Question: Give a one-sentence summary of this figure.
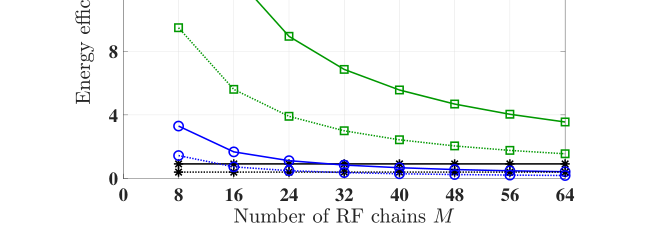
Answer: , Fig. 9 and Fig. 10 compare the energy efficiency versus the number of RF chains, number of UEs and number of RHS elements in various beamformers, respectively. Firstly, Fig. 8 shows that the energy efficiency decreases upon de- ploying more RF chains due to the power consumption of RF chains. Furthermore, the switch-controlled RHS beamforming architectures have higher energy efficiency than the fully digital beamforming architecture and fully-connected PSA beamforming architecture. Fig. 9 portrays that the energy efficiency increases almost linearly with the number of UEs. Fig. 10 shows that with the increase of the number of RHS elements, the energy efficiency of the switch-controlled RHS beamforming architecture is much higher than that of the fully digital beamforming architecture and fully-connected PSA beamforming architecture. Furthermore, the energy ef- ficiency of the fully digital beamforming architecture, the fully-connected PSA beamforming architecture was reduced